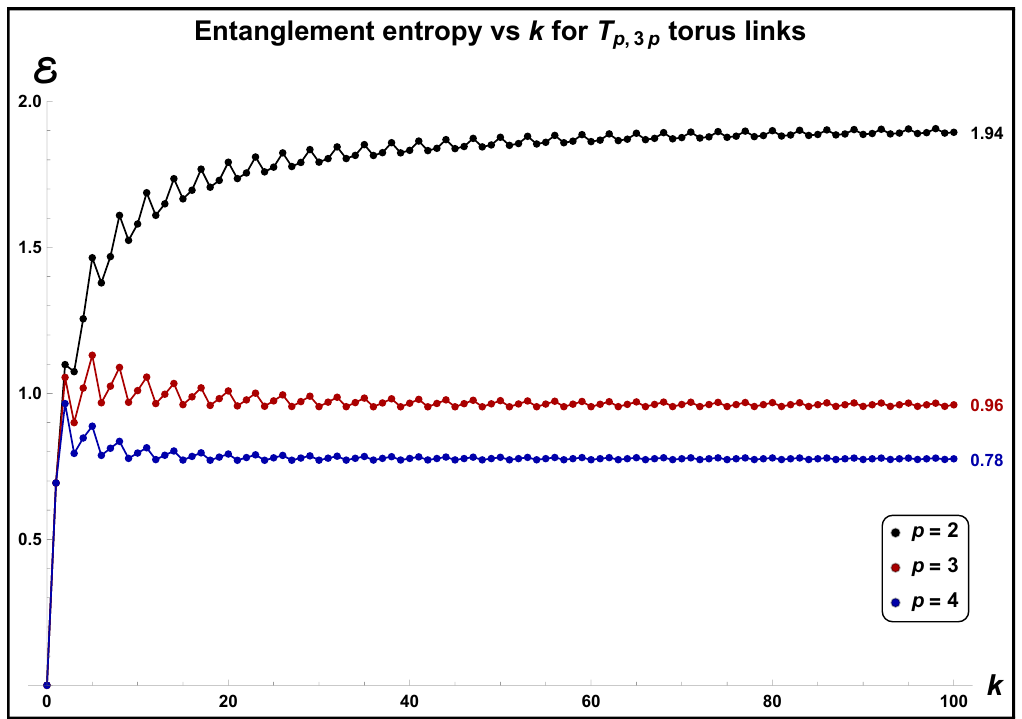
Figure 7. The variation of the SU (2) k entanglement entropy with k for T p, 3 p torus links. For each plot, we see three distinct patterns of entropy depending upon the values of ‘ ∈ { 0 , 1 , 2 } . As k becomes large, the three patterns converge to a unique value which is given in (4.35). The corresponding values up to 2 decimal places have been indicated against each